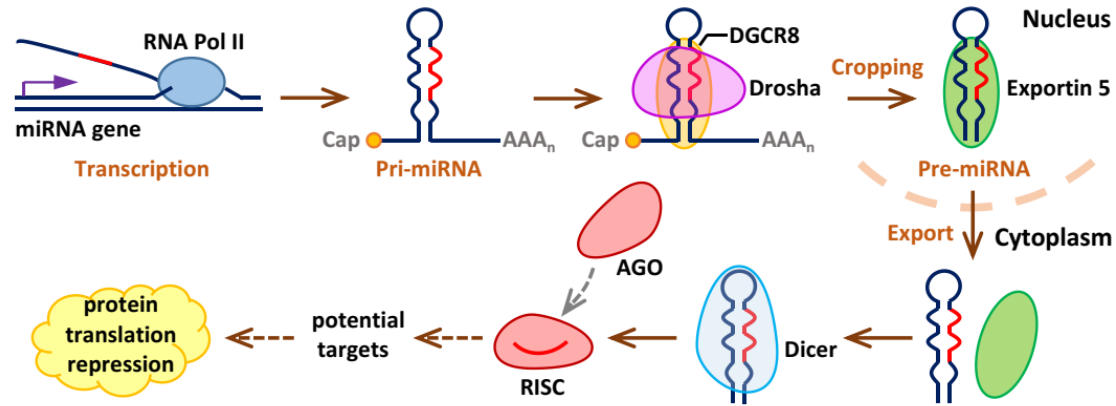
Figure 1. Model of canonical microRNA biogenesis .